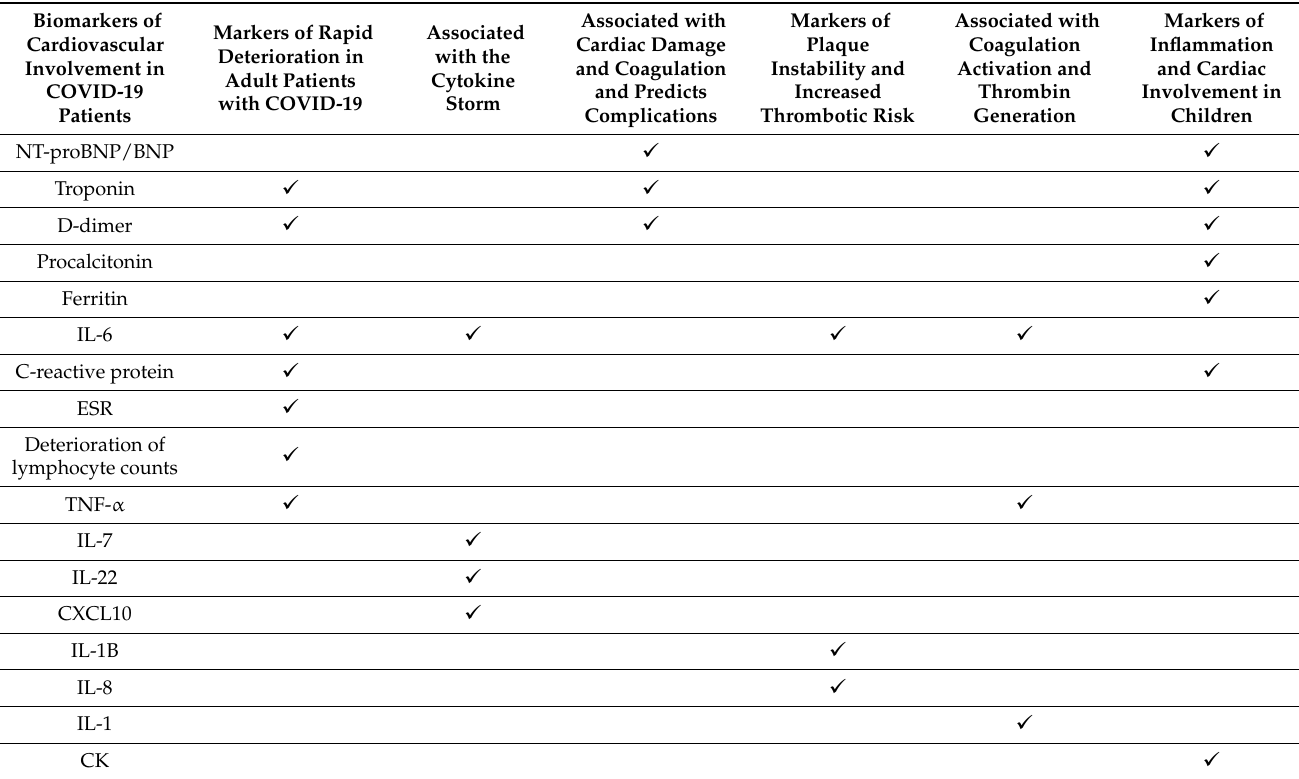
: indicates the association between the biomarker and respective cardiovascular complication